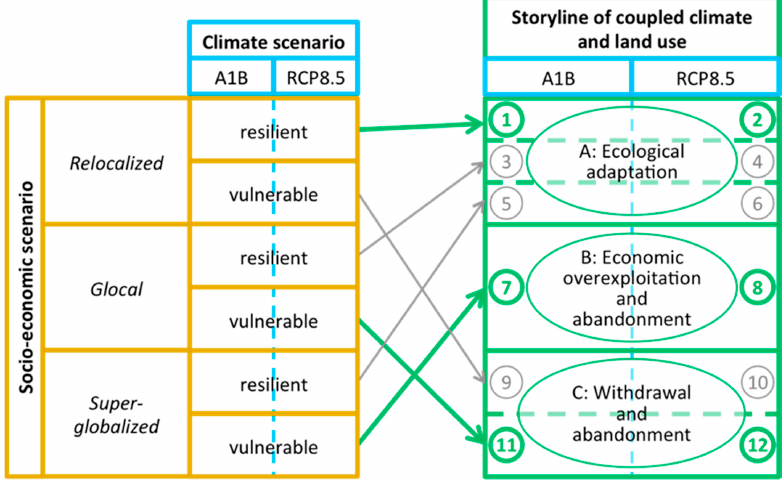
Figure 3. Classification of storylines according to the forest/land use and climate developments. The bold arrows and numbers indicate the scenarios chosen as input to the hydrological modelling. We discussed the storylines in a first participative [49,50] workshop with local representatives of different stakeholder groups on their consistency and plausibility. In a next step, we discussed their consequences for land-use change and forest management with two experts from the district and provincial forestry departments. As some of the storylines turned out to have quite similar consequences on land use, we reduced the six socio-economic scenarios to three distinct pathways of forest management, namely: (A) ecological adaptation, (B) economic overexploitation and abandonment, and (C) withdrawal and abandonment (Figure 3, right side). (A) Ecological adaptation : Forest management consistently applies the guidelines outlined in the forest development plan (“Waldentwicklungsplan”) issued by the federal ministry. The forest cover is dominated by an ecological, place-adapted mixed cultivation with a harmonious age structure. This makes the forest generally resilient to natural hazards while it continues to fulfil its different functions. Marginal land on steep slopes is reforested, mountain pastures are used for cattle and sheep as today. Natural reforestation is partly possible due to extensification which is already ongoing. This represents a socio-economic scenario of resilient relocalization. The communities act innovatively and proactively. They favour, for instance, the use of local wood chips for communal heating systems and coordinate the supply chain for quality timber in the hands of local craft businesses. Climate change is perceived as an opportunity to act in coordinated fashion towards a sustainable future. Local supply chains and eco-tourism (mainly for summer tourism) retain the value added locally. Agriculture makes optimum use of the prolonged vegetation period, diversifies the product range and, in combination with local off- farm employment possibilities, slows down structural change. Mountain summer farms specialize on the provision of local food to tourists, along with animal herding, thus most of them continue in operation. (B) Economic overexploitation and abandonment : Management is guided by short-term economic considerations, and results in a focus on increased efficiency and cost reduction at the expense of long-term ecological considerations. Nevertheless, legal regulations are respected and new, adapted, species are reforested (e.g., Douglas fir). After a short intensive phase of forestry use and overexploitation, the actors lose their economic interest in the forest as profits decrease. The